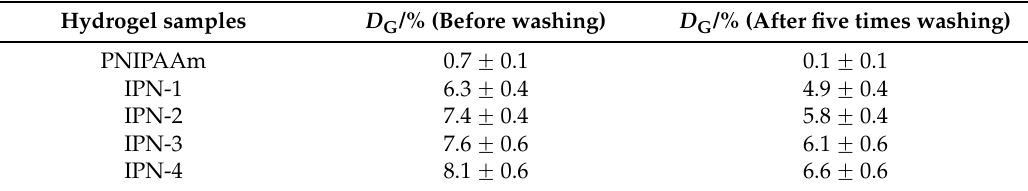
Table 2. Grafting degree of cotton fabric.